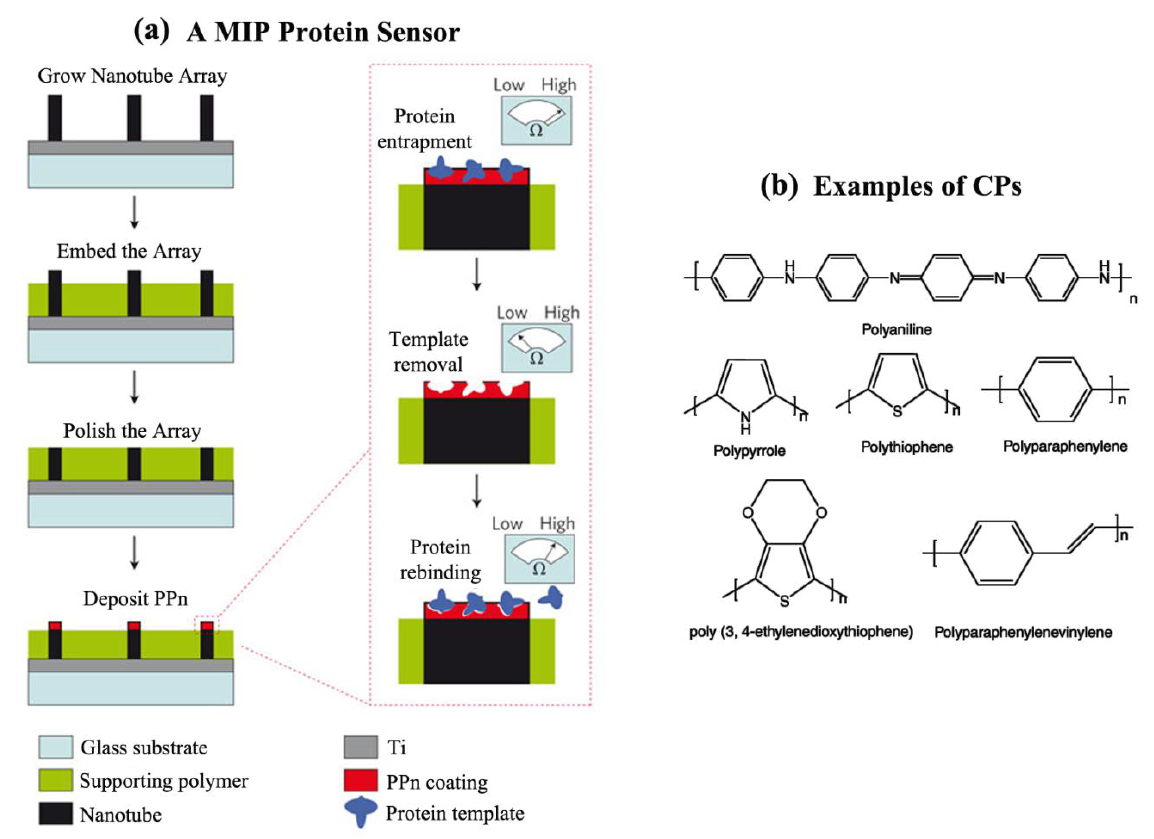
Figure 2. Molecular imprinting polymers (MIPs) and conducting polymers (CPs). ( a ) An electrochemical protein sensor employing a MIP and ( b ) typical examples of CPs. Adapted with permission from [80] and